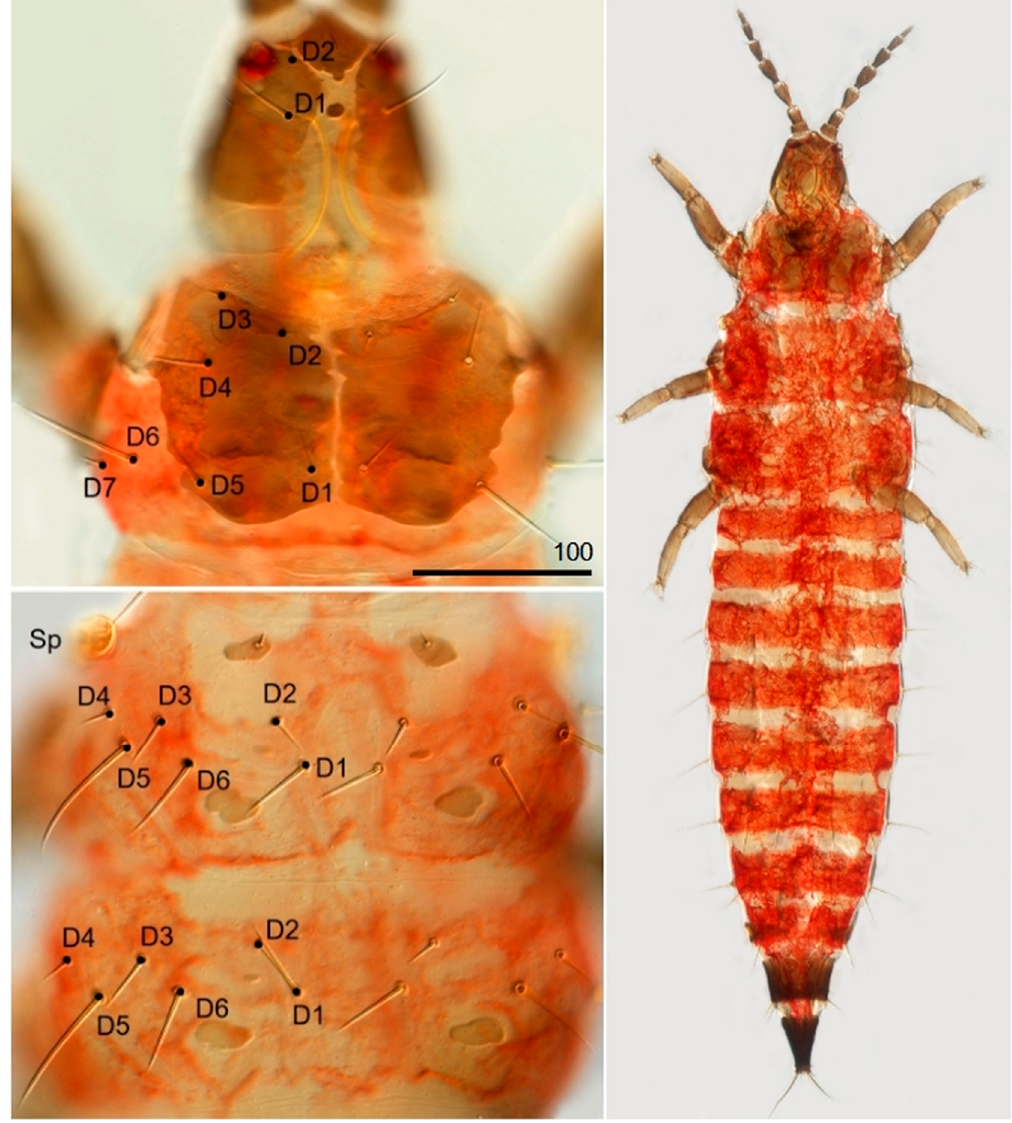
Figure A1. H. leucanthemi —second larval instar: body view ( right ), head and pronotum ( left , above ), meso- and metanotum ( left , below ), Sp—spiracle, D1–D7—dorsal setae on head and thorax included in morphometric measurements (Table